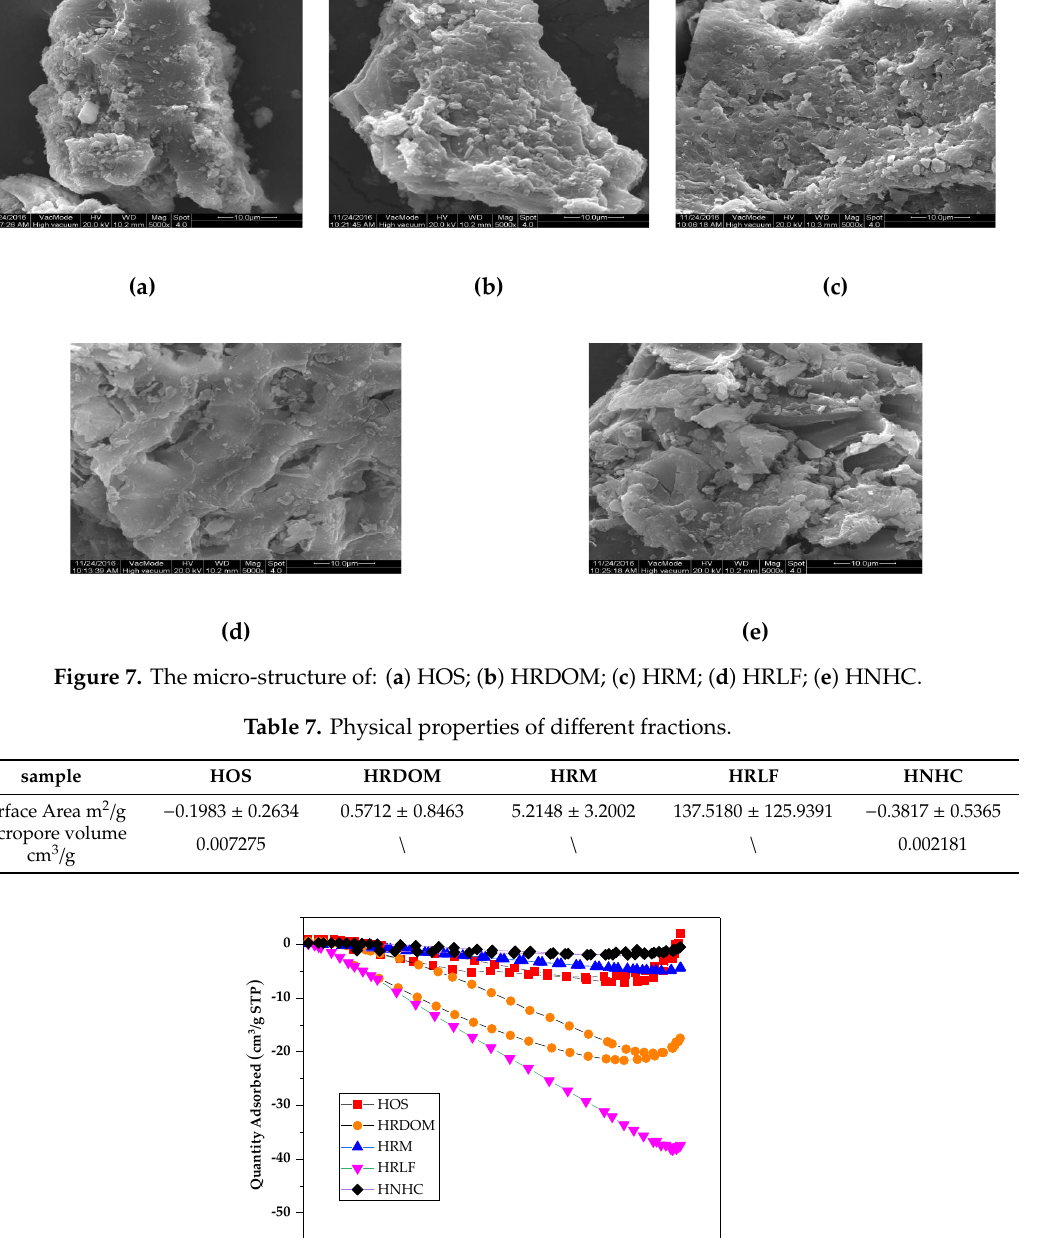
Figure 8. N 2 adsorption-desorption isotherms of different fractions. Table 7. Physical properties of different fractions